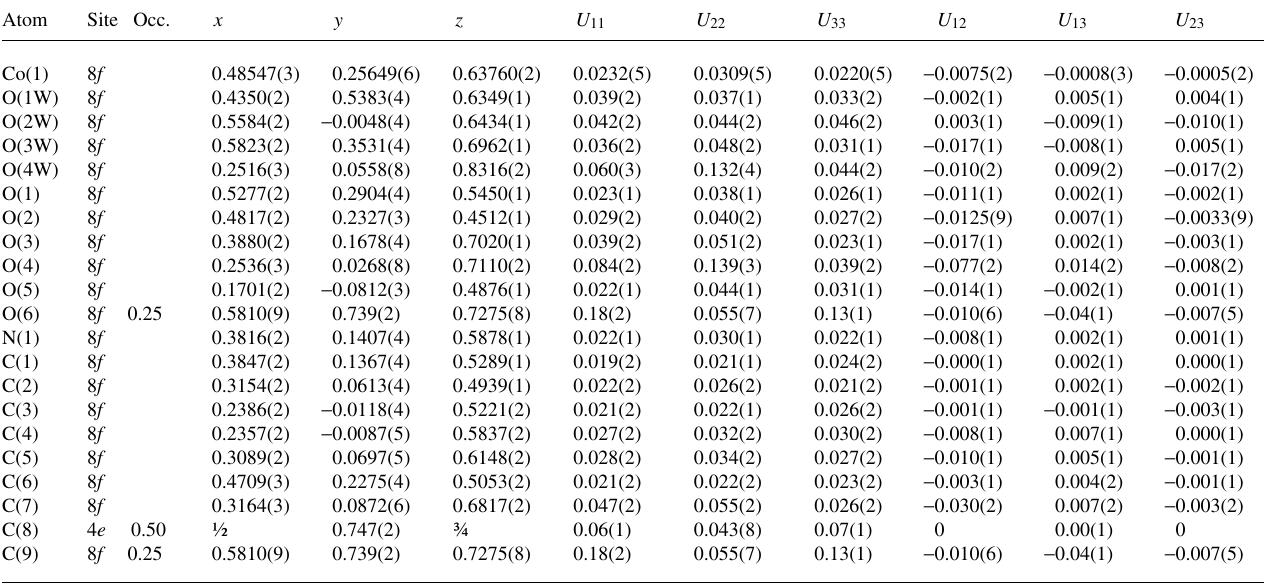
Table 3. Atomic coordinates and displacement parameters (in Å 2 ) .